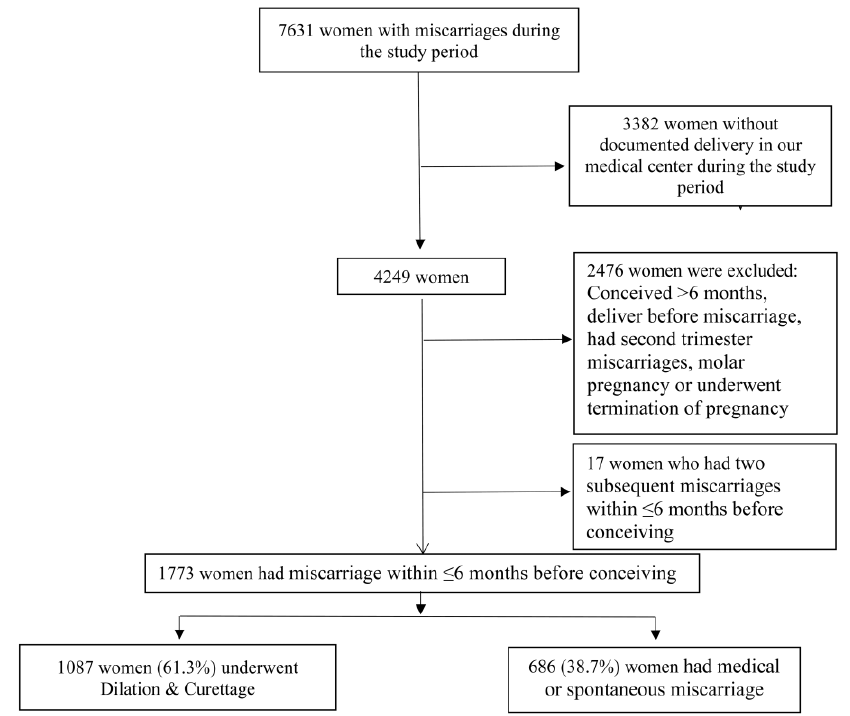
Figure 1. Schematic Study Flowchart.